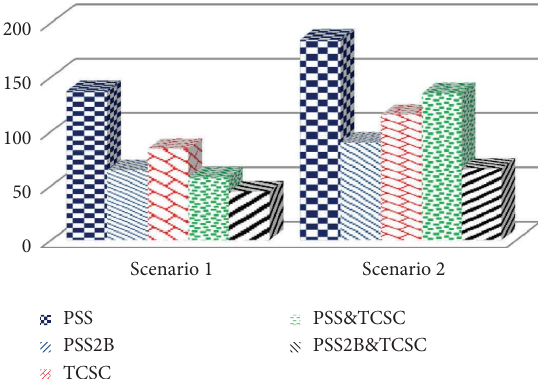
Figure 17: Te values of the ITAE criterion. Figure 18: Values of the FD